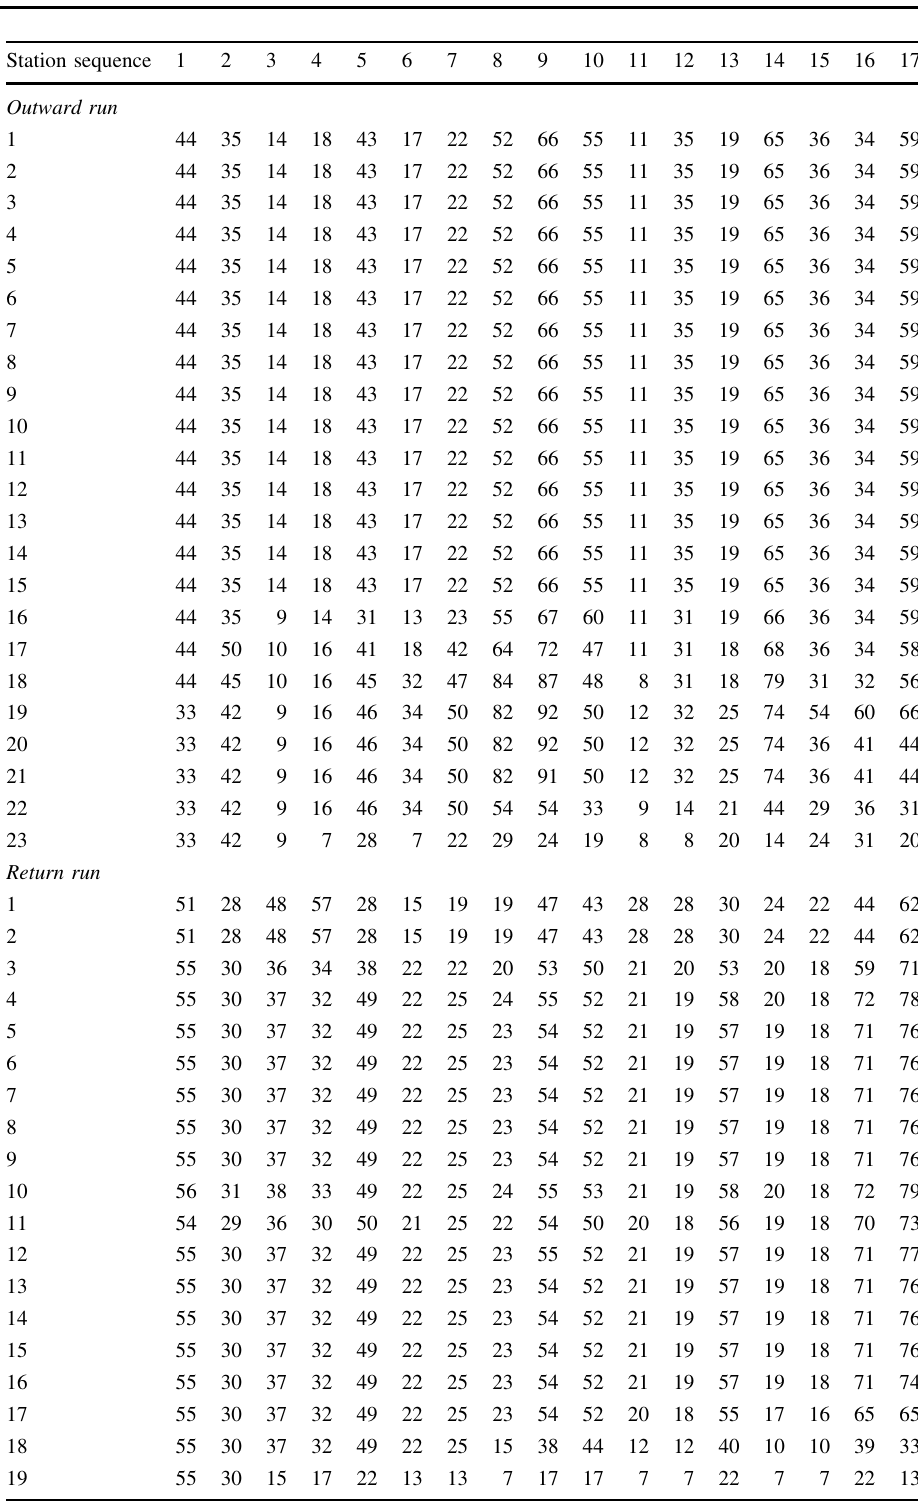
Urban Rail Transit (2017)